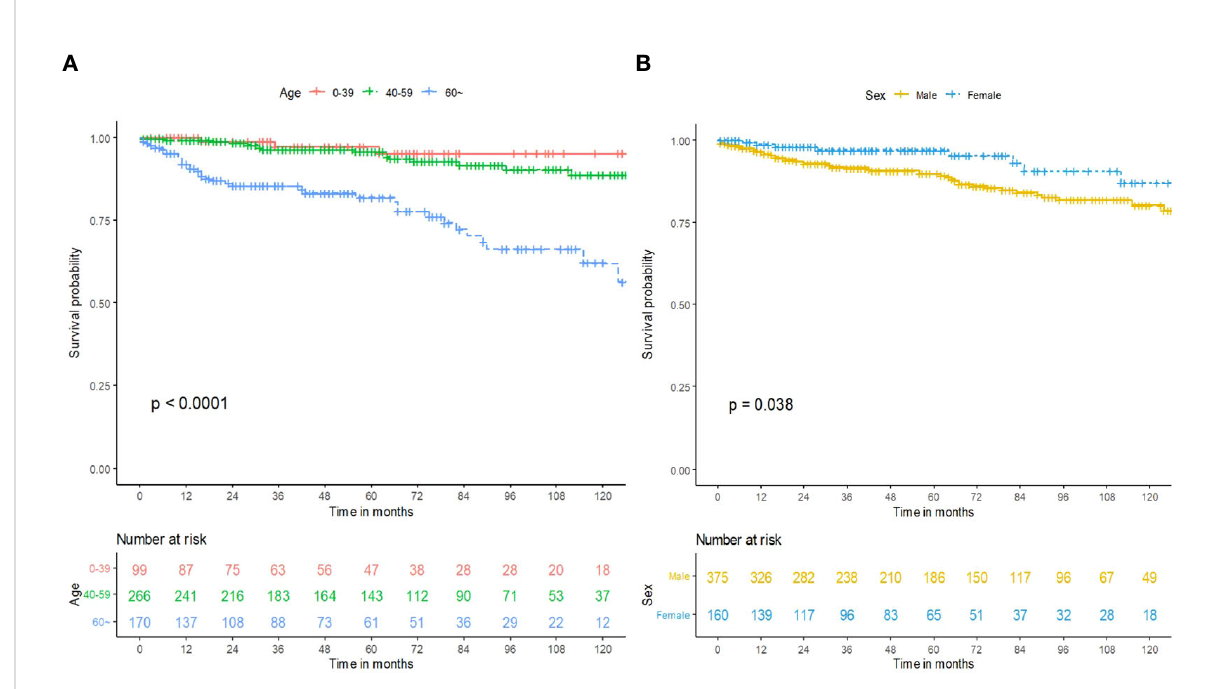
FIGURE 2 Prognosis of intracranial subependymoma for OS in the training cohort. (A) OS between the different age groups. (B) OS between the different sex groups. OS, overall